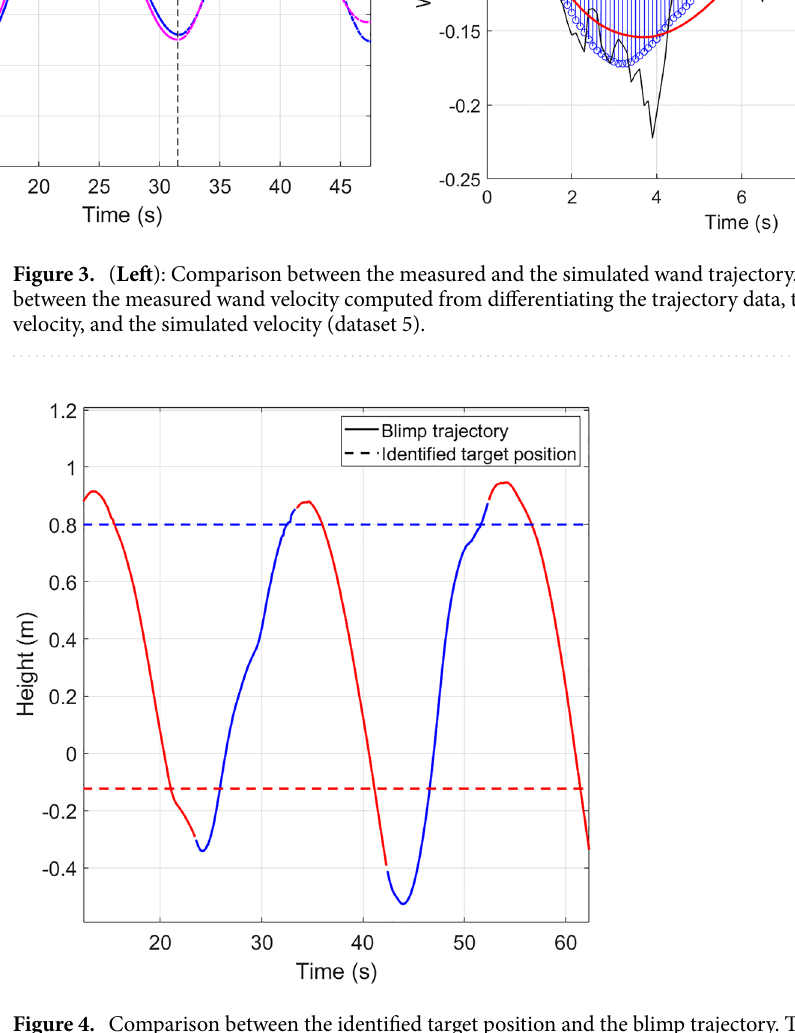
Figure 4. Comparison between the identified target position and the blimp trajectory. The blue and red solid lines show the blimp trajectory in the going-up/down segments, respectively, and the blue and red dashed lines show the identified target position for the going-up/down